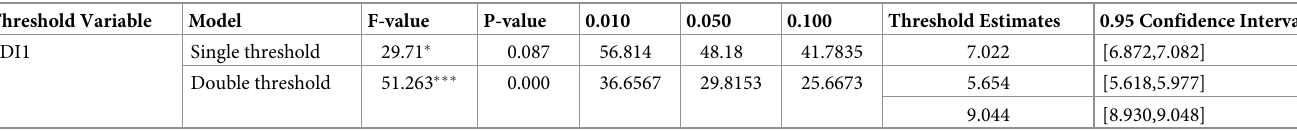
Table 3. FDI quantity threshold significance test and confidence intervals.